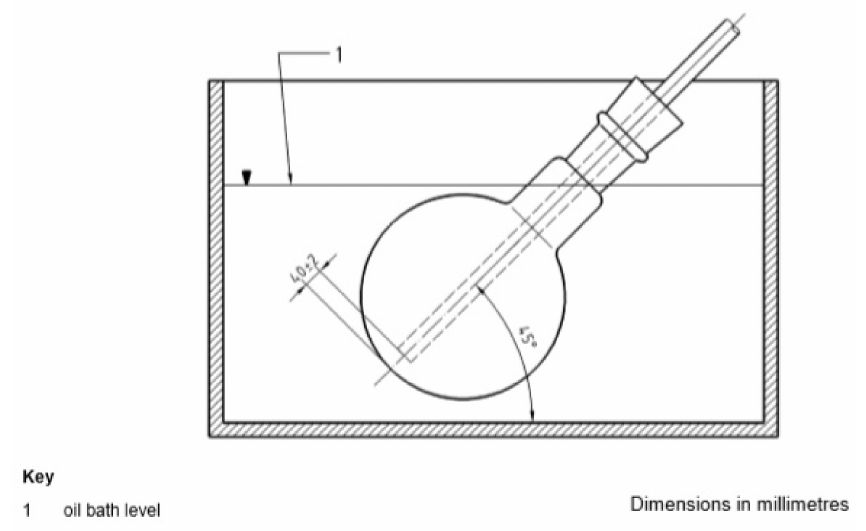
Figure 6. Schematic of RFT aging setup [EN